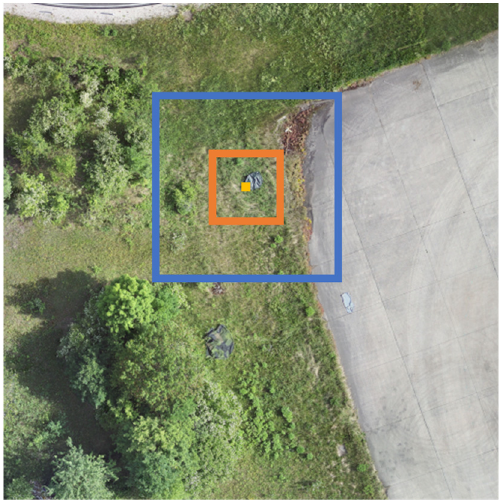
Figure 5. Dual window neighborhood principle for anomaly detection. For the pixel under test (marked yellow), only pixels that are inside the blue window but outside the orange area are considered for estimating its anomaly score.